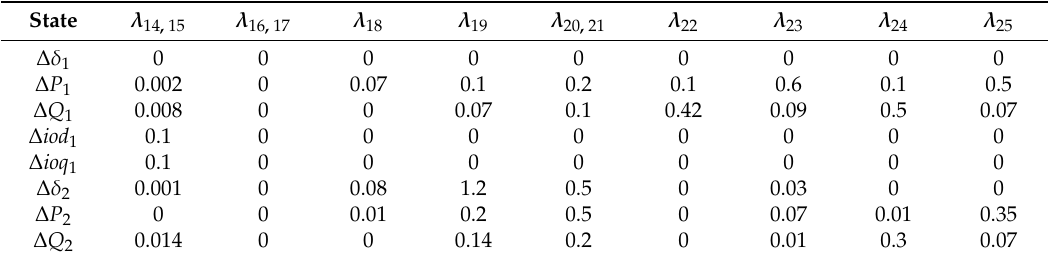
Table 6. Phase / power participation factors in selected